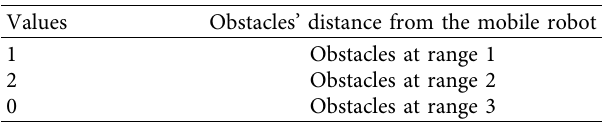
Table 3: Sample input values from the US used in ANN to identify obstacles’ location referring to the defined ranges in Table 2.